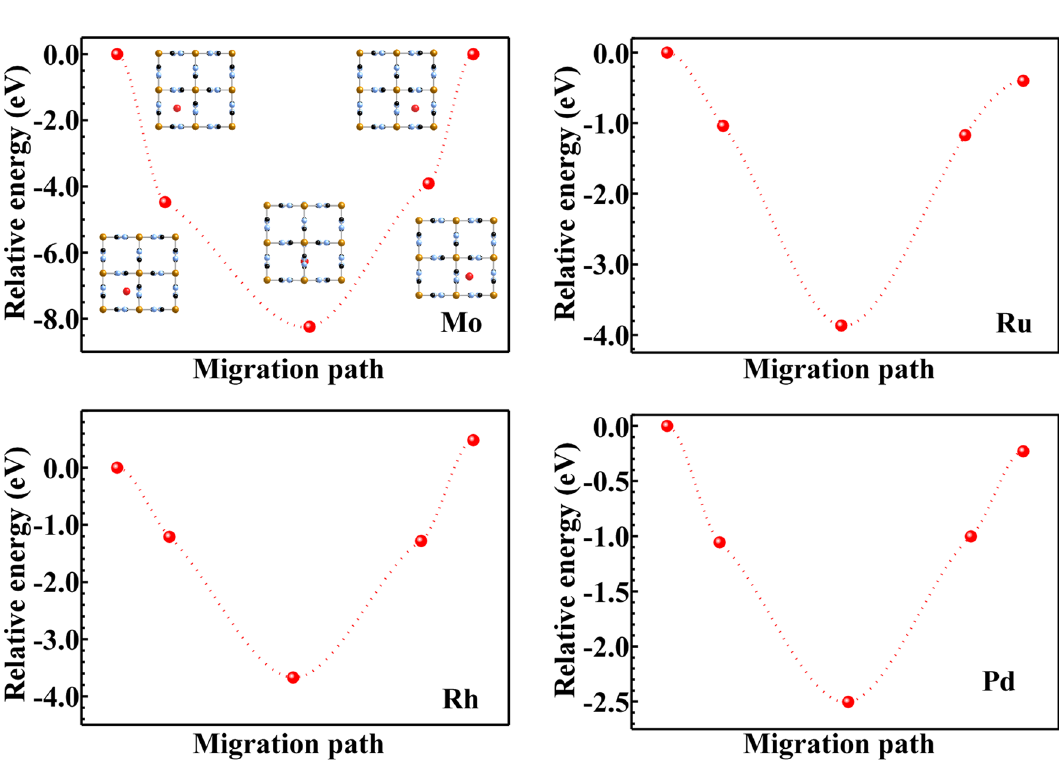
Figure 4. Relative energy of PGMs/Mo ions into PB jungle-gym structure at each migration step for the diffusion model. Inset shows the snap shot of each migration step in the nanospace of PB unit